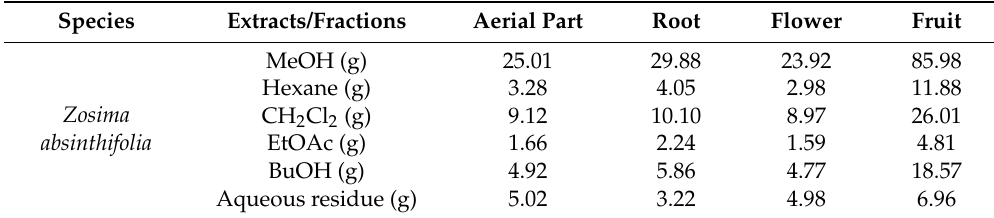
Table 6. Weights of the crushed plants and obtained extracts and fractions. Species Extracts/Fractions Aerial Part Root Flower Fruit MeOH Zosima absinthifolia